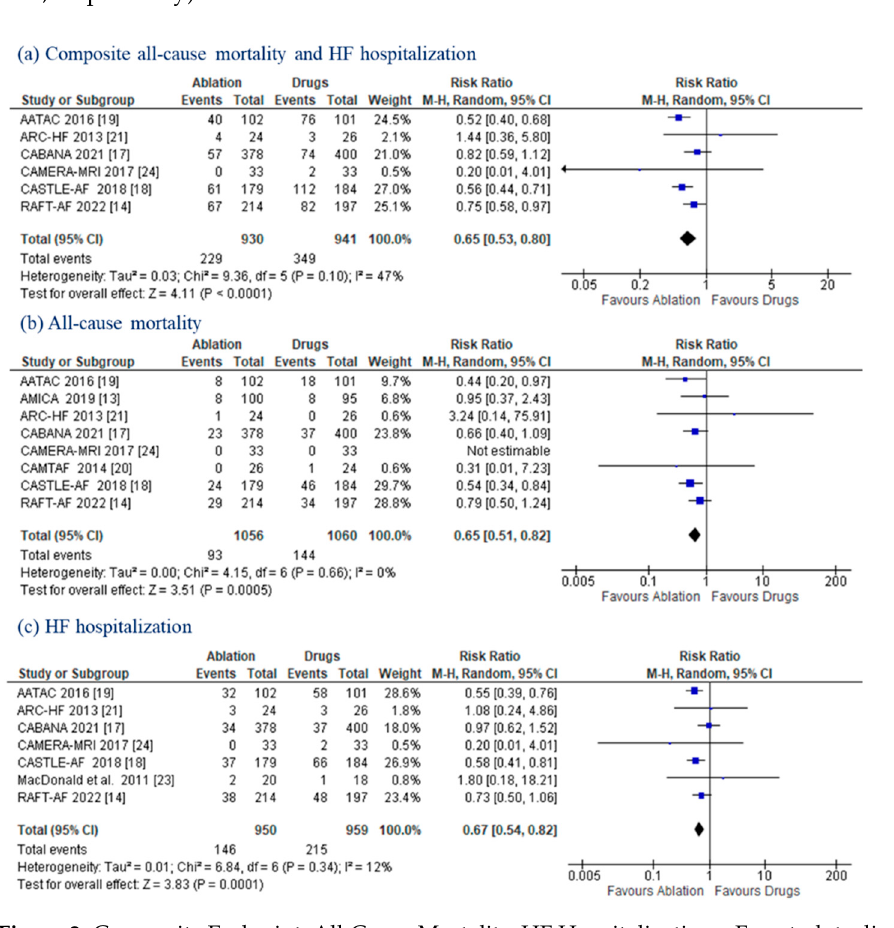
Figure 3. AF Recurrence and CV Death. Forest plots displaying risk ratio in AF recurrence ( a ) and cardiovascular death ( b ) between the ablation and drug groups. AF: